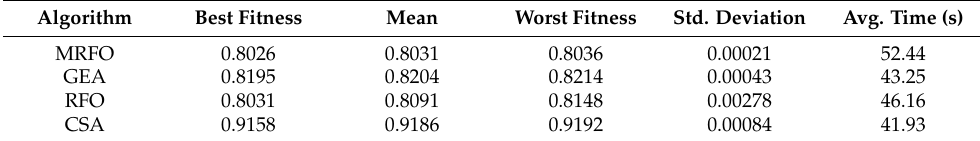
Table 3. Statistical comparison of the algorithms over 40 runs.